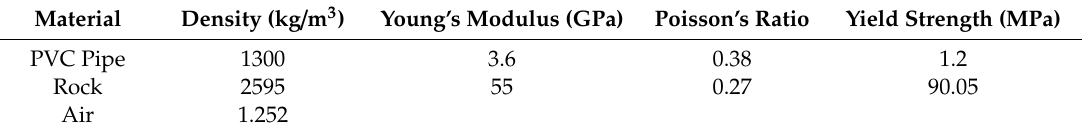
Table 2. Model’s material parameters.